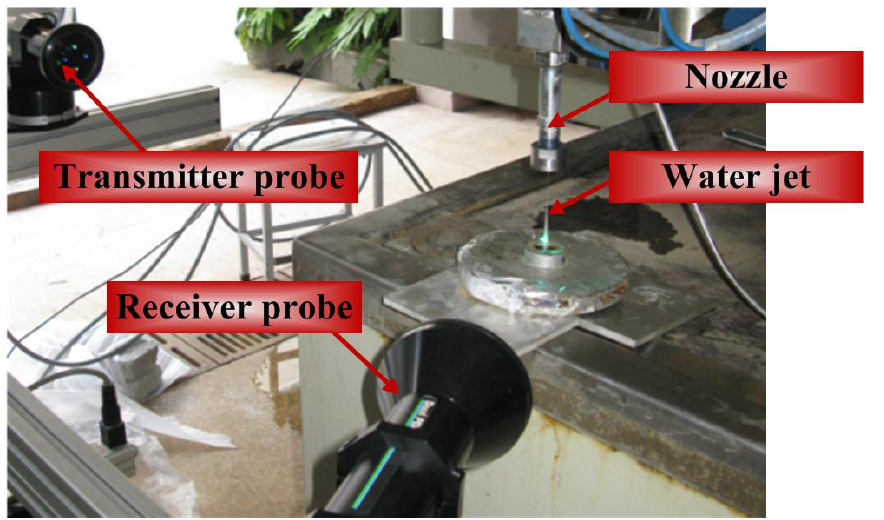
Figure 2. Configuration of the experimental